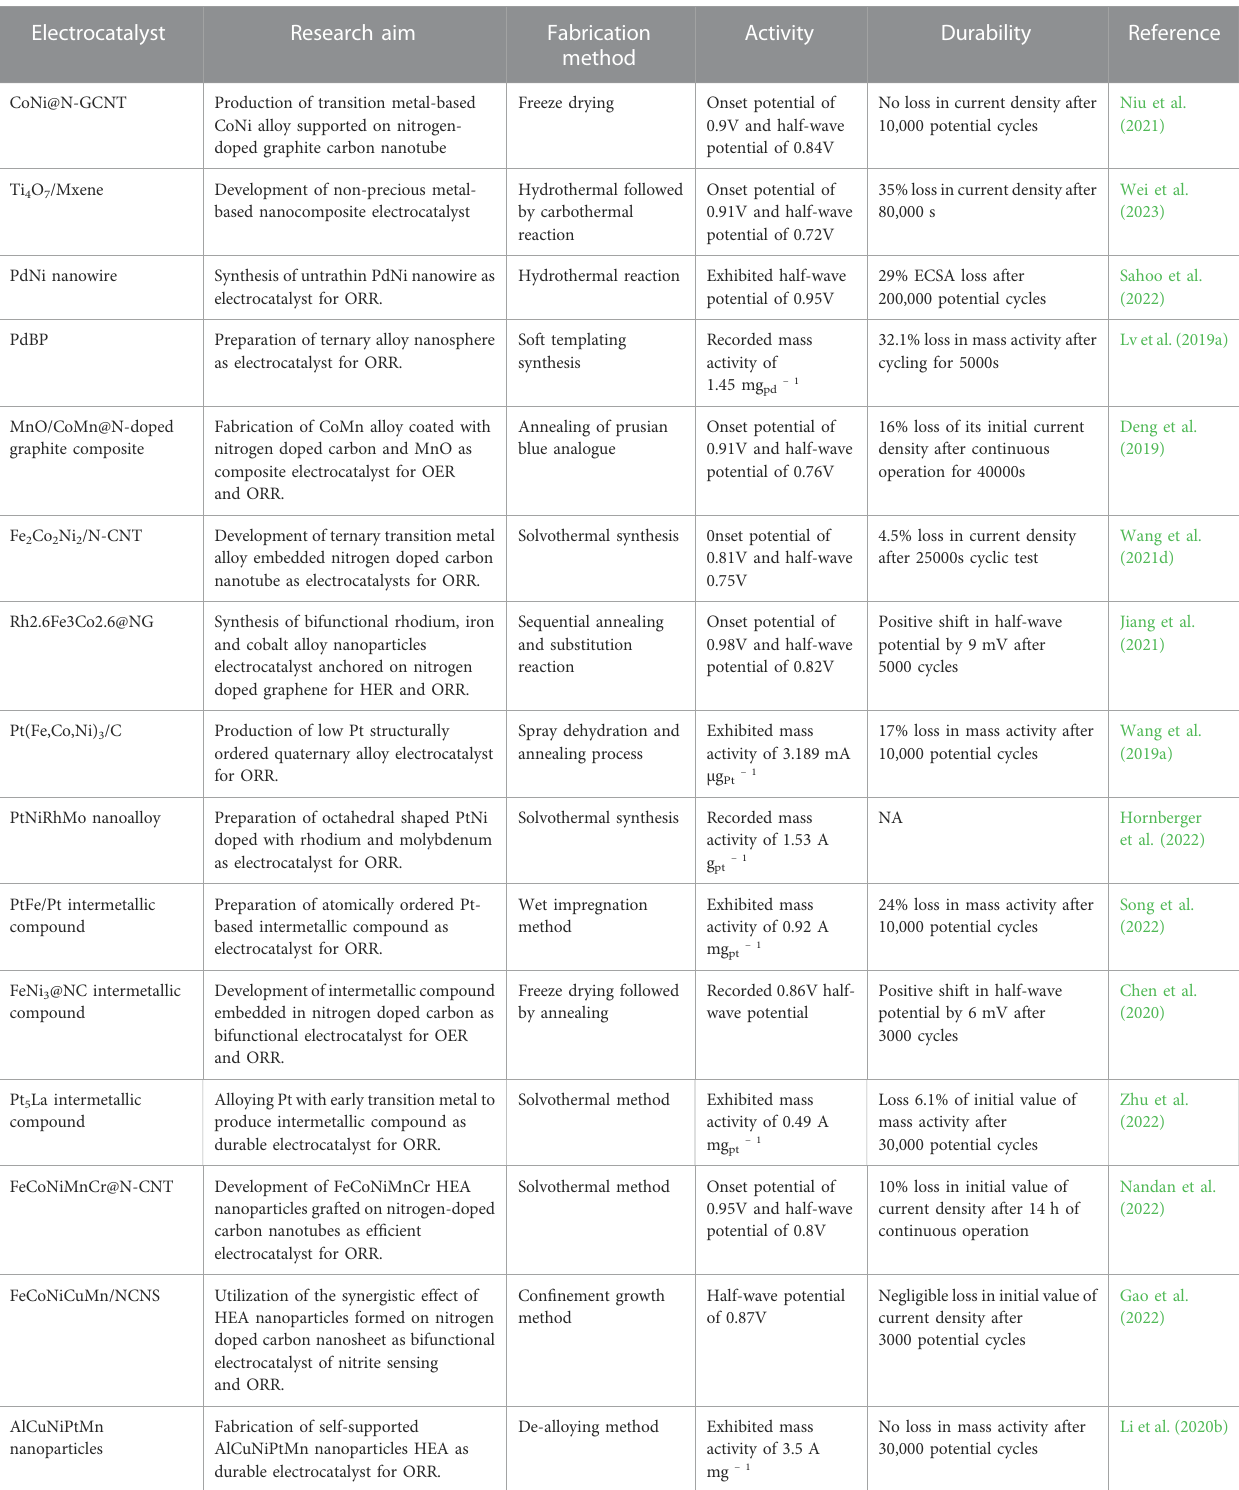
TABLE 4 Alloy-based electrocatalyst and their